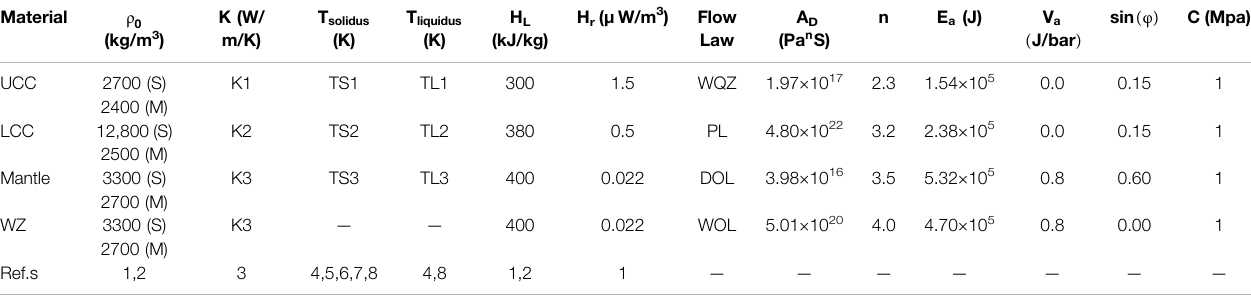
TABLE 1 | Material properties used in the numerical experiments.